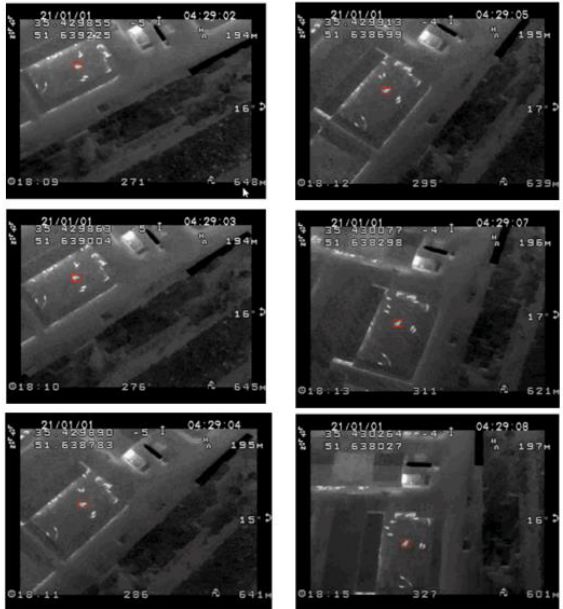
Figure 4: Target tracked in the sequence of successive frames